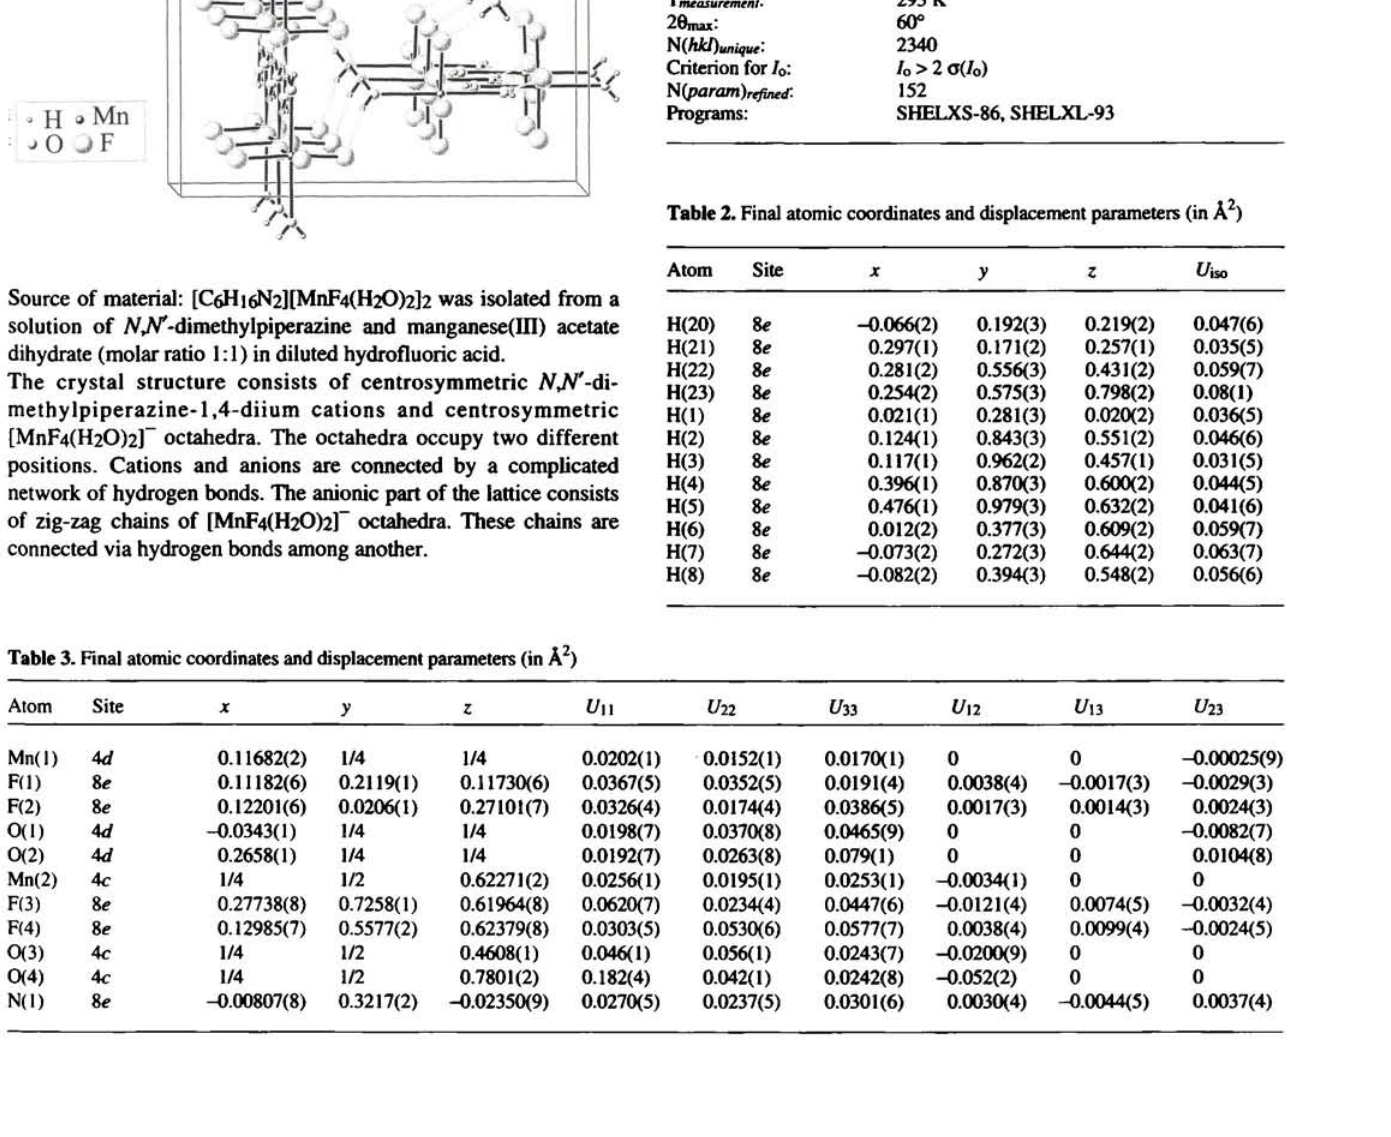
Table 1. Parameters used for the X-ray data collection Crystal: